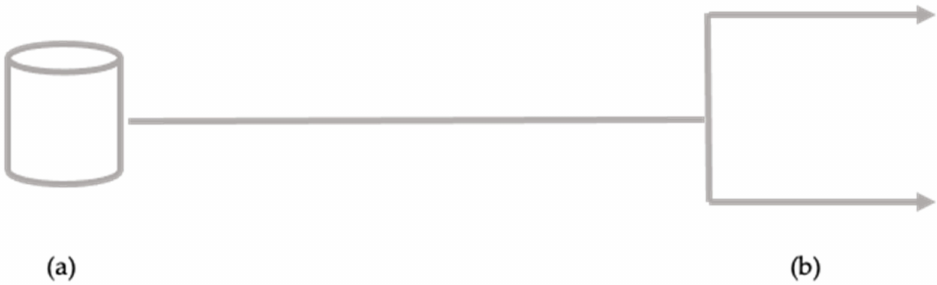
Figure 3. Process diagram of water pipeline from the AQP. ( a ) Water source—AQP; ( b ) distribution networks.